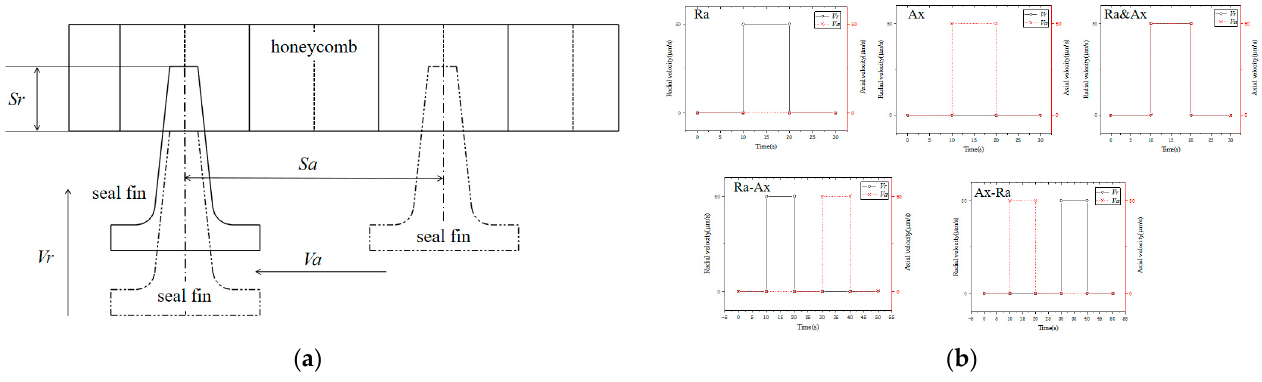
Figure 6. Schematic diagram of rubbing parameters. ( a ) Schematic diagram of Vr , Va , Sr , and Sa . ( b ) Schematic diagram of rubbing models. Table 4. Test conditions for the influence of different rubbing modes on crack initiation.